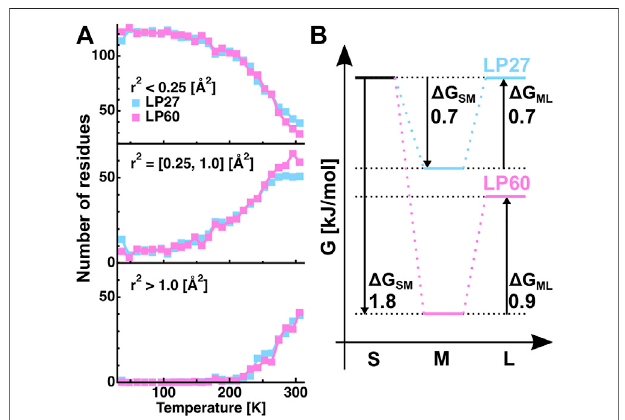
FIGURE 7 | Analysis of the distributions of the squared position fl uctuation obtained by the MSPF analysis. (A) : Temperature dependence of thenumberofresiduesundergoingmotionswithsmall[ r 2 < 0.25(Å 2 )],medium [0.25 (Å 2 ) ≤ r 2 ≤ 1.0 (Å 2 )], and largeamplitudes [1.0 (Å 2 ) < r 2 ],which were calculated based on the β values of Figure 6D . (B) : Free energy differences between the states of motions of the small, medium, and large amplitudes, which were estimated from the number of residues contained in each state shown in Figure 7A at 306 K. “ S ” , “ M ” , and “ L ” denote the small, medium, and large amplitudes, respectively. Δ G SM and Δ G ML denote the free energy differences between the S and M states, and between the M and L states, respectively.Thenumericalvaluesof Δ G SM and Δ G ML areintheunitofkJ/mol. The freeenergy ofthefraction ofatoms withsmallamplitudesofLP27 isset to be the same as that of LP60.